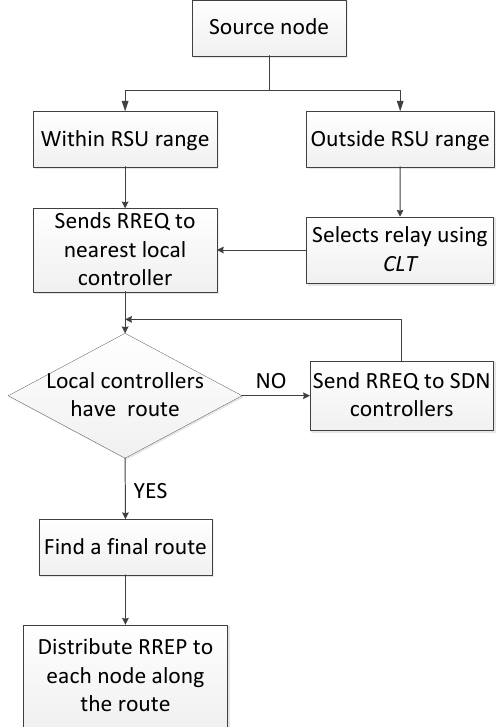
Figure 4. A flowchart representing two cases of local controllers finding a final route.